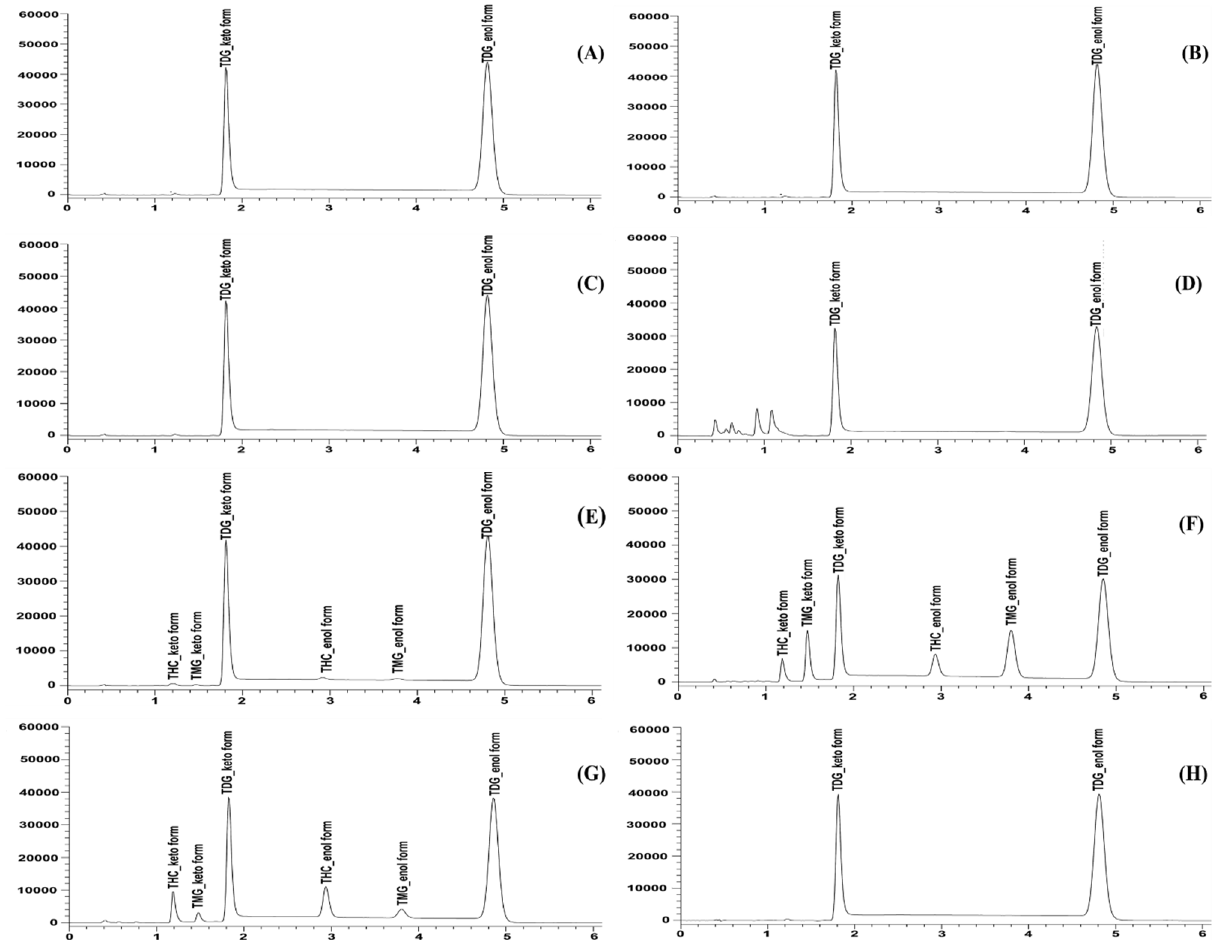
Figure 3. The chromatograms of forced degradation samples of tetrahydrocurcumin di-glutaric acid (TDG) under ( A ) photolysis (liquid), ( B ) photolysis (solid), ( C ) thermal stress, ( D ) oxidative stress, ( E ) moisture hydrolysis, ( F ) basic hydrolysis, ( G ) acid hydrolysis, and ( H ) control conditions. Table 2. Peak purity values of tetrahydrocurcumin di ‐ glutaric acid (TDG) under stress conditions. (cid:1) Peak Purity Index Peak Purity Index Single Point Treatment (Keto) (Enol) Threshold Control (untreated) 0.999999